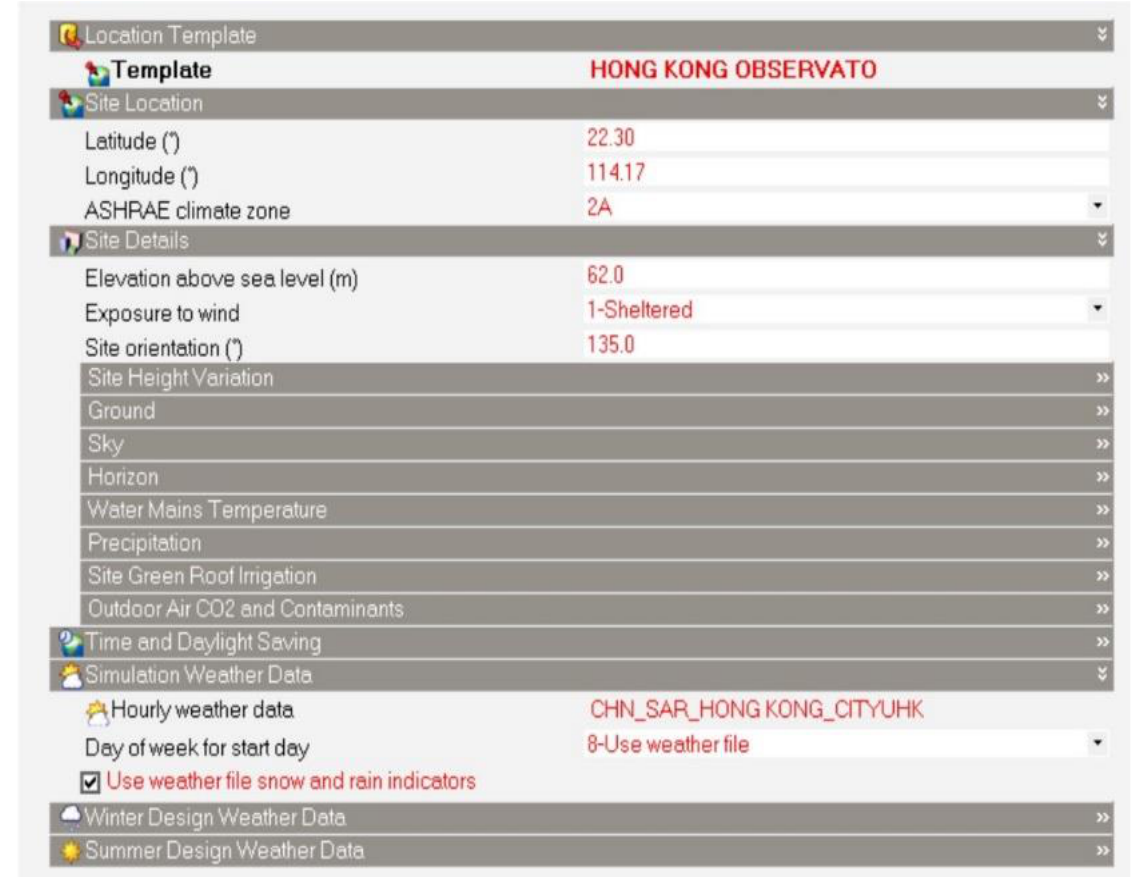
Figure 5. Location settings for energy modelling. Figure 7a,b show the variations in energy consumption in Model 1 and Model 2. Energy consumption in both mixed-development and full-residential use peaks from May to September during summer and hits its lowest level from December to February in winter. The total annual energy consumption is 922 MWh for Model 1 and 759 MWh for Model 2. While the results show similarity in pattern, the mixed-development Model 1 identifies a 21% higher energy consumption due to the difference in cooling, lighting, and miscellaneous equipment. This is mainly due to the retail space’s functionality and higher power intensity (W/m 2 ). For example, the retail portion includes a retail shop with a higher power intensity (16 W/m 2 ) than residential spaces such as a bedroom (13 W/m 2 ). The main parameters contributing to energy consumption are cooling, lighting, and miscellaneous equipment. The cooling load takes up 48% and 46% of the total energy consumption of Model 1 and Model 2, respectively, nearly half the total annual energy consumption. Meanwhile, lighting takes up 22% of the total yearly consumption in both models, and the figure is almost constant monthly. Similarly, although miscellaneous equipment makes up 15% and 18% of energy consumption in the respective models, its monthly energy demand is very stable. Other parameters, such as domestic hot water, pump, and lift, remain almost the same, making the cooling load the main contributor to the observed